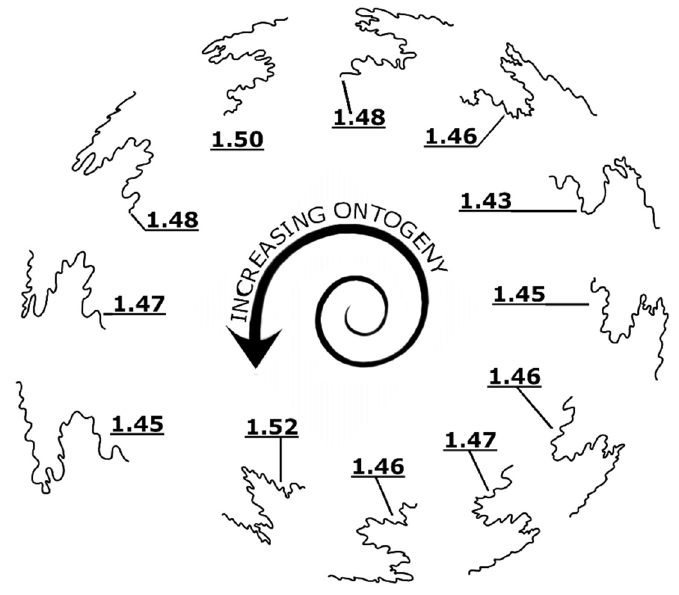
Figure 8. Ontogenetic sequences of perisphinctoid Craspedites nodiger .